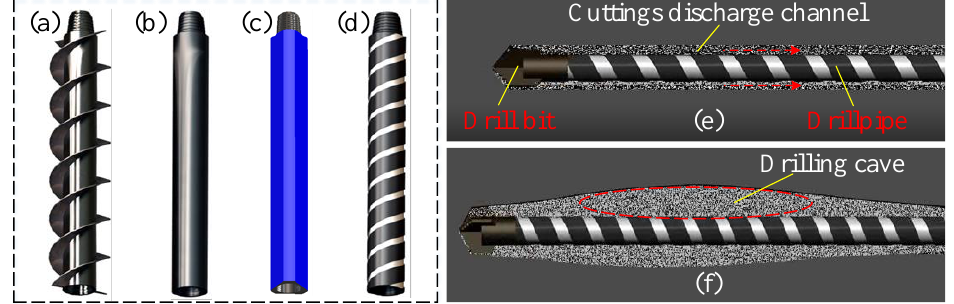
Figure 1. Drilling techniques in soft and outburst-prone coal seam. ( a ) Spiral blade drill pipe; ( b ) smooth-surfaced drill pipe; ( c ) prismatic drill pipe; ( d ) grooved drill pipe; ( e ) normal drilling condition; and ( f ) drill pipe jamming.